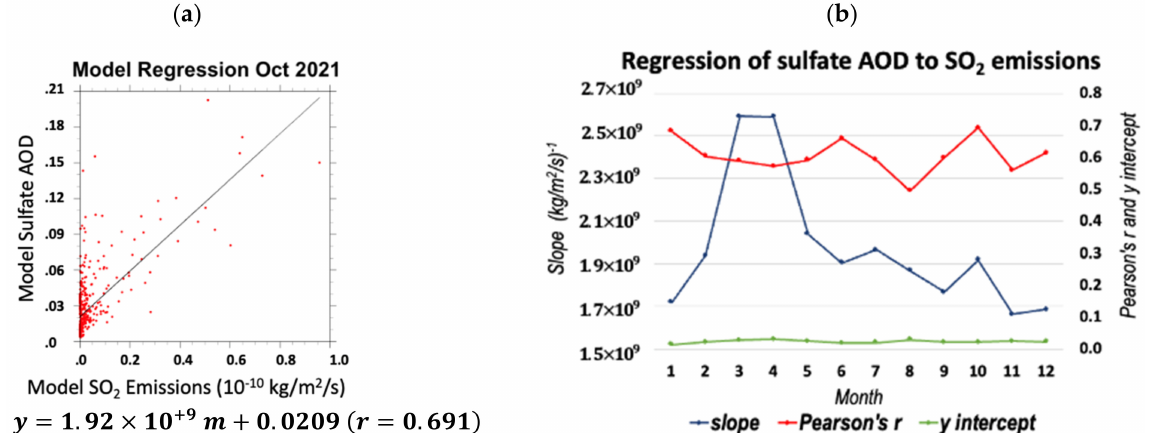
Figure 4. ( a ) The regression of SO 2 emissions (CEDS 2019) and SENS1 model sulfate AOD in October 2021. ( b ) Monthly values of the regressions in 2021. A high-to-low resolution, regional-scale filter (12 ◦ × 6 ◦ ) was applied to both the model and emissions data for the regression. This amounts to a total of 900 grid